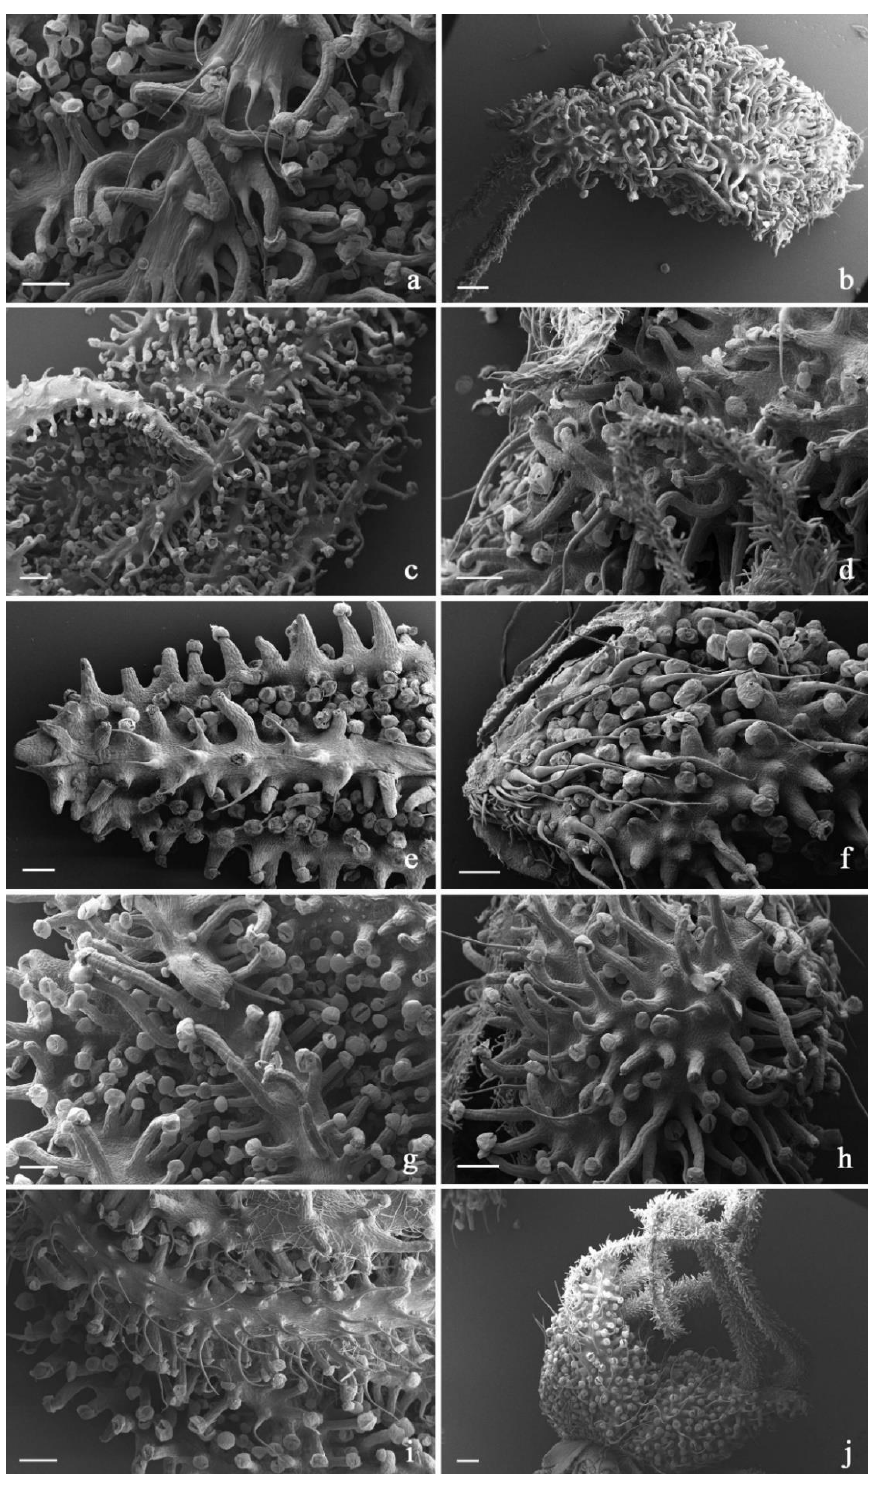
Figure 8. SEM micrographs showing the trichome distribution pattern on bracts and bracteoles of the investigated C. sativa varieties. ( a , b ) 24 K hemp variety: abaxial surfaces of bract ( a ) and bracteole ( b ); ( c , d ) Gorilla Glue hemp variety: abaxial surfaces of bract ( c ) and bracteole ( d ); ( e , f ) Lemon Conti Kush hemp variety: abaxial surfaces of bract ( e ) and bracteole ( f ); ( g , h ) Fresh Mountain hemp variety: abaxial surfaces of bract ( g ) and bracteole ( h ); ( i , j ) Amnesia Cookies hemp variety: abaxial surfaces of bract ( i ) and bracteole ( j ). Scale bars = 200 µ m ( a , c – i ); 250 µ m ( b , j )